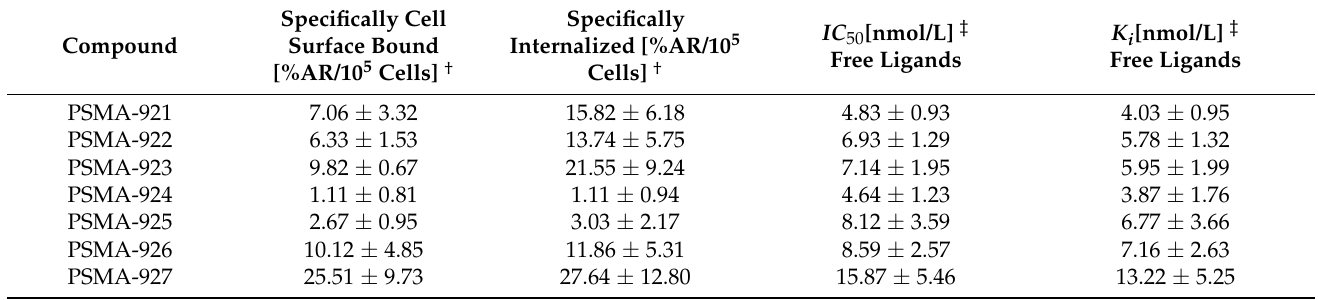
Table 1. Cell binding and internalization data of all candidates of the hybrid molecule library